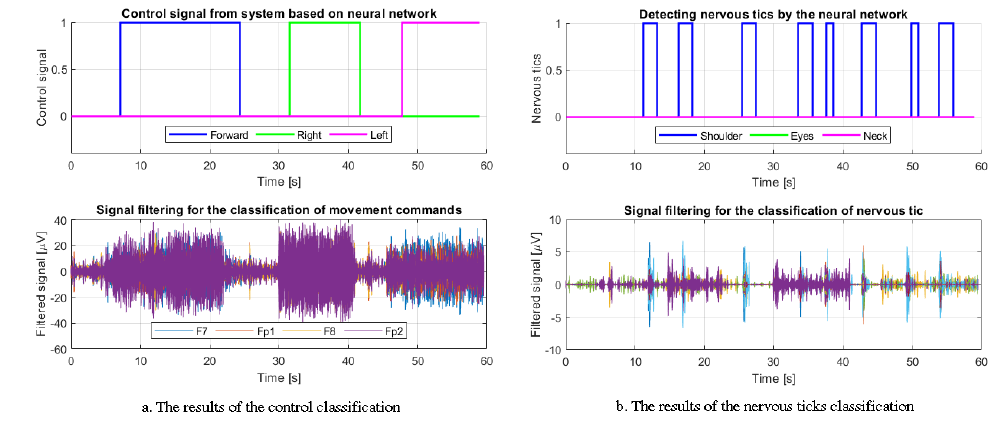
Figure 17. An example of the classification of movement commands and nervous tics—shoulder muscles